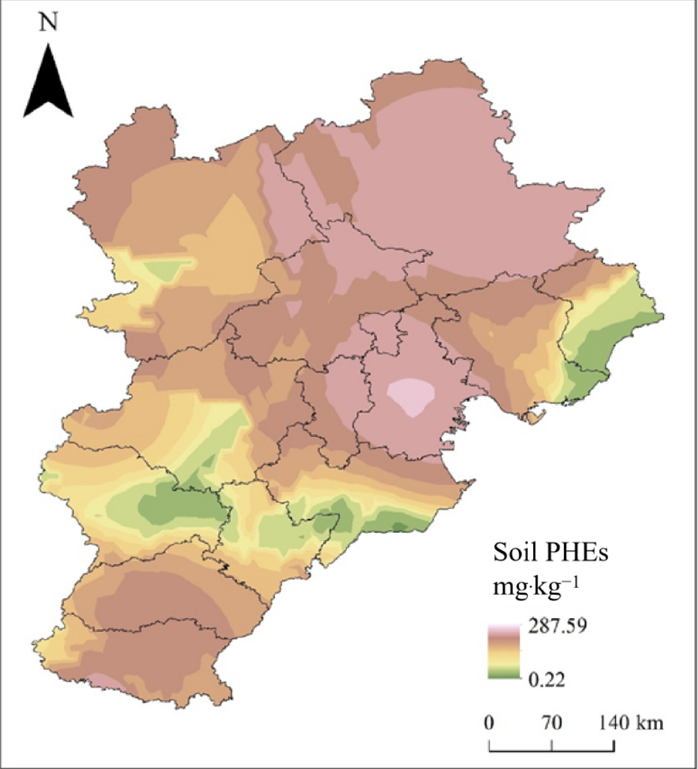
Figure 4. Sum of the eight PHEs after the discharge and deposition of PHEs from coking enterprises.